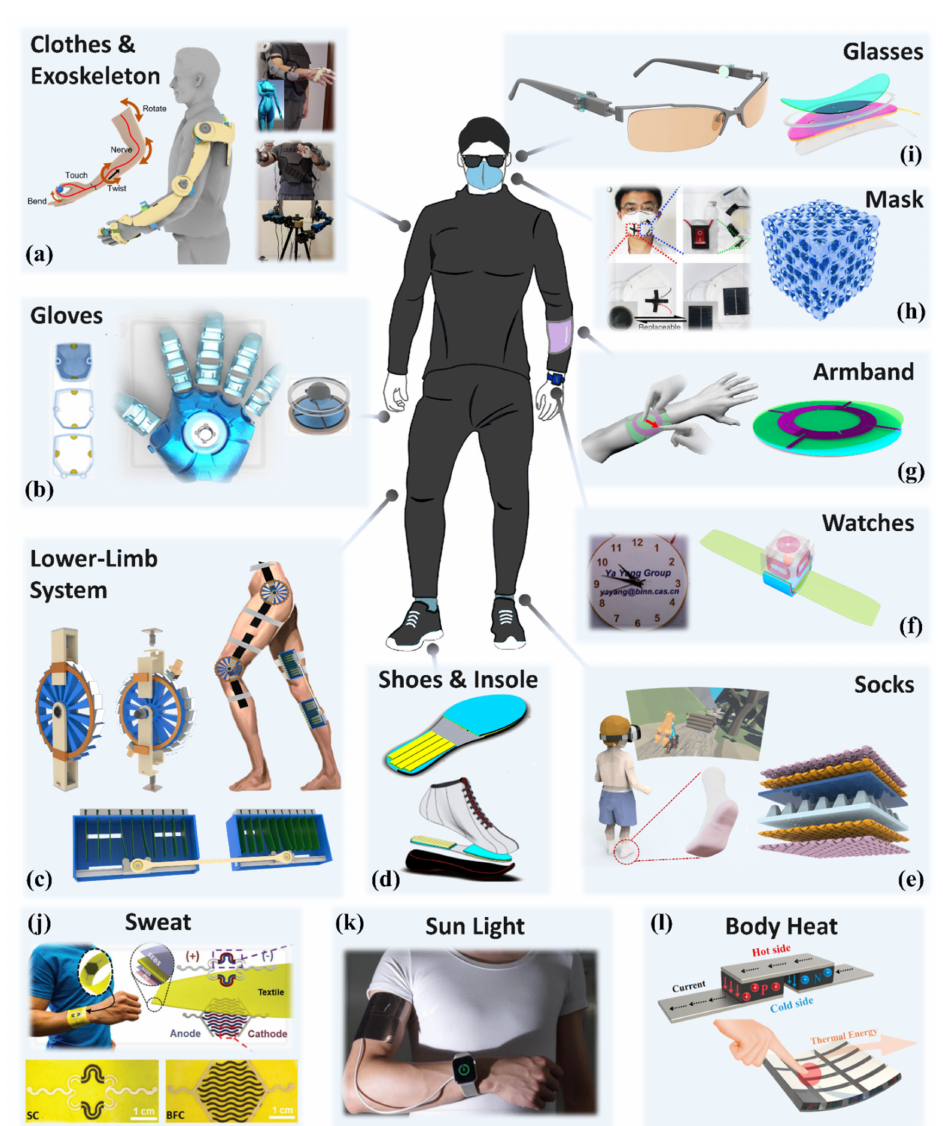
Figure 2. Self-powered sensor and energy harvesters: ( a ) devices applied on clothes and exoskeleton (Reprinted with permission from ref. [148]. Copyright 2021 Nature); ( b ) devices equipped on gloves (Reprinted with permission from ref. [149]. Copyright 2020 American Association for the Advancement of Science); ( c ) structures designed for lower limb (Reprinted with permission from ref. [150]. Copyright 2021 John Wiley & Sons); ( d ) devices applied in shoes and insole (Reprinted with permission from ref. [151]. Copyright 2020 American Chemical Society); ( e ) TENG-based smart socks (Reprinted with permission from ref. [152]. Copyright 2020 Nature); ( f ) hybridized energy harvester as a self- powered watch (Reprinted with permission from ref. [153]. Copyright 2015 American Chemical Society); ( g ) flexible TENG patch as an armband for human-machine interface (Reprinted with permission from ref. [154]. Copyright 2019 Elsevier); ( h ) self-powered air filter applied in a mask (Reprinted with permission from ref. [155]. Copyright 2020 Nature); ( i ) eye motion triggered self-powered sensing system equipped on glasses (Reprinted with permission from ref. [156]. Copyright 2017 American Association for the Advancement of Science); ( j ) hybrid textile devices for harvesting biochemical energy from sweat (Reprinted with permission from ref. [157]. Copyright 2018 Royal Society of Chemistry); ( k ) flexible perovskite solar cell for harvesting energy from light (Reprinted with permission from ref. [158]. Copyright 2020 Nature); ( l ) flexible thermoelectric generator for harvesting energy from body heat (Reprinted with permission from ref. [159]. Copyright 2019 American Chemical